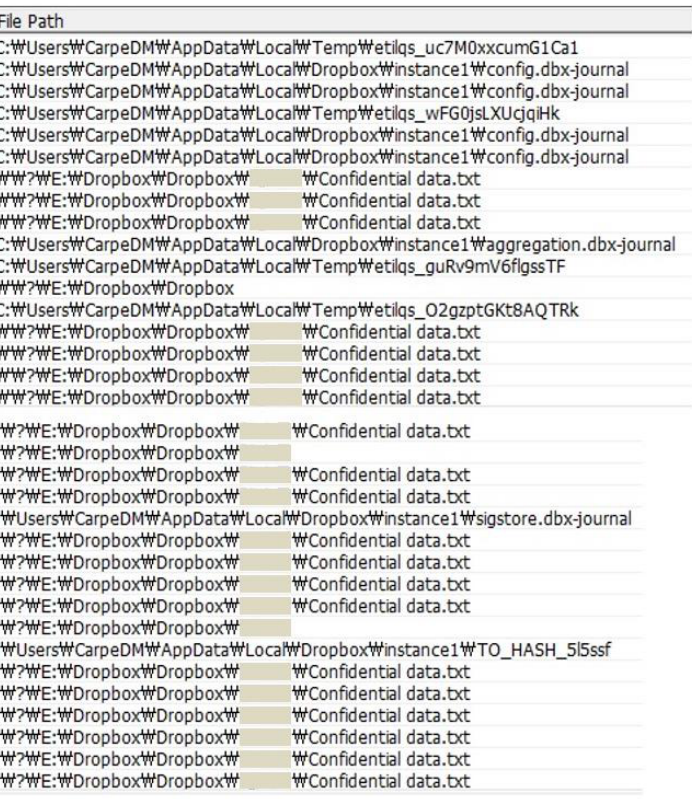
Figure 3. Synchronized file paths extracted from the detection module.